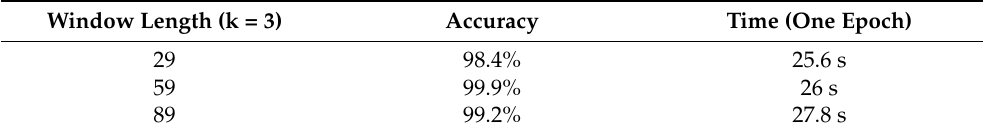
Table 4. The influence of different experimental parameters on experimental results. Window Length (k = 3) Accuracy Time (One Epoch)